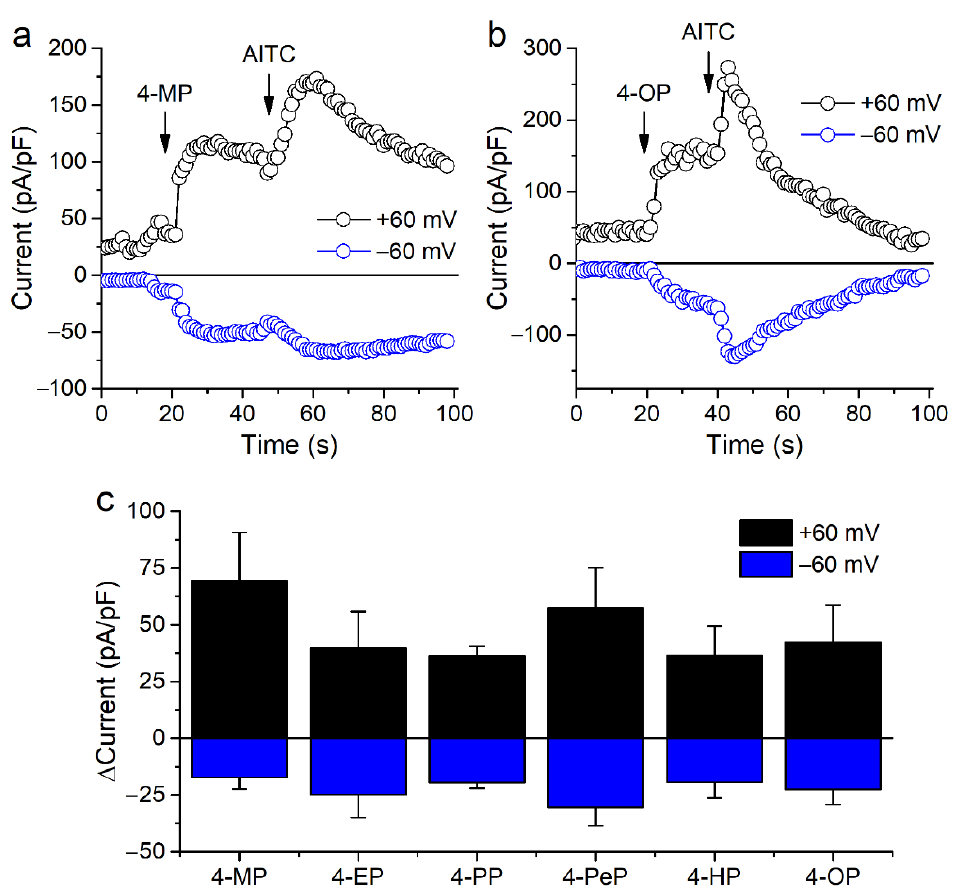
Figure 2. Alkylphenols stimulate mTRPA1 currents. ( a , b ) Time course of mTRPA1 current amplitudes measured at − 60 and +60 mV. 4-methylphenol (4-MP), 4-octylphenol (4-OP) and allyl isothiocyanate (AITC; 100 µ M) were applied at the time points indicated by the arrows. ( c ) Change in current densities at − 60 and +60 mV induced by 4-MP (1500 µ M), 4-EP (600 µ M), 4-PP (100 µ M), 4-PeP (200 µ M), 4-HP (30 µ M), 4-OP (30 µ M). Data is shown as mean ± s.e.m. ( n ≥ 4).